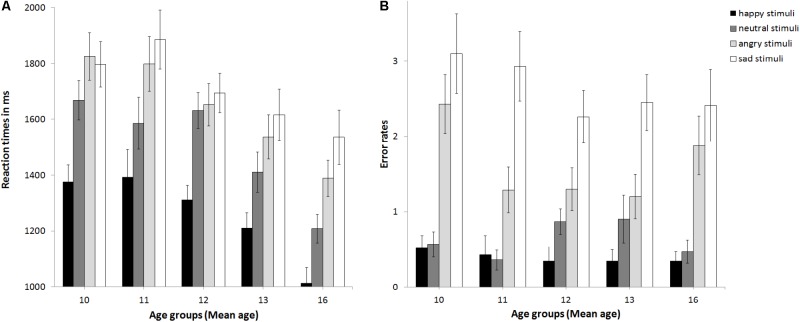
Mean reaction times (A) and error rates (B) as a function of age group. Error bars indicate SEM.